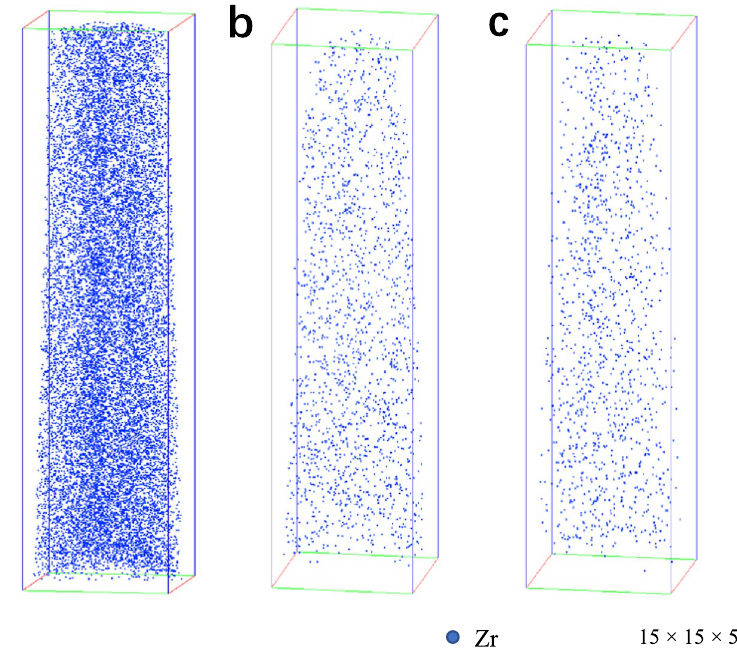
Figure 5. Representative 3DAP images to show the Zr atom distribution in the Al matrix in the I-type ( a ), II- type-400 ( b ), and III-type-265 ( c ) Al-Zr conductors, respectively. Only Zr atoms are shown in the 3DAP images for clearly revealing the Zr